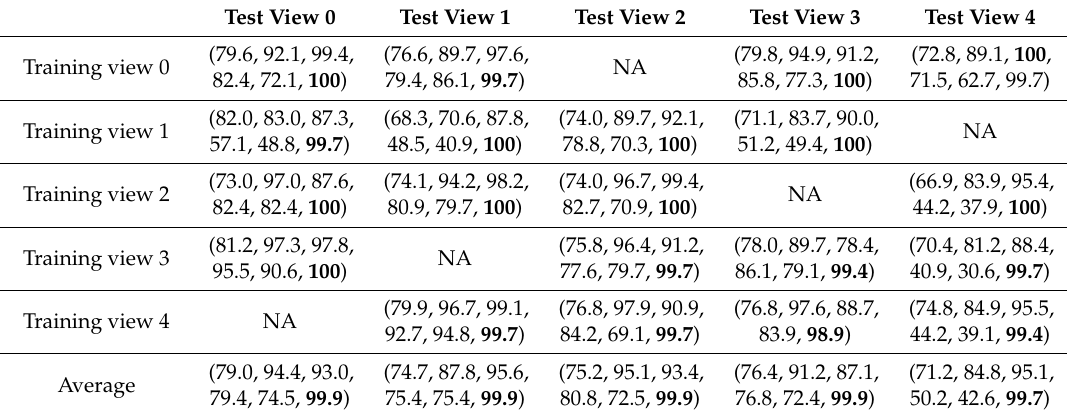
Table 3. One-to-one cross-view recognition results of various unsupervised approaches on the IXMAS dataset. The results in brackets are the recognition accuracies of [8,27–29,43], and our unsupervised approach, respectively.